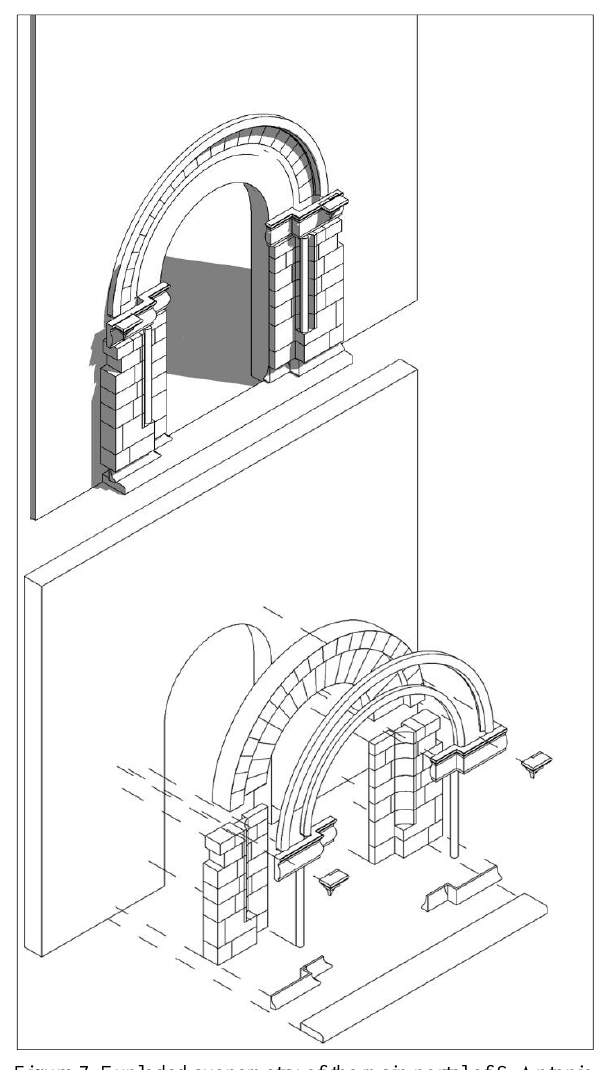
Figure 7. Exploded axonometry of the main portal of S.